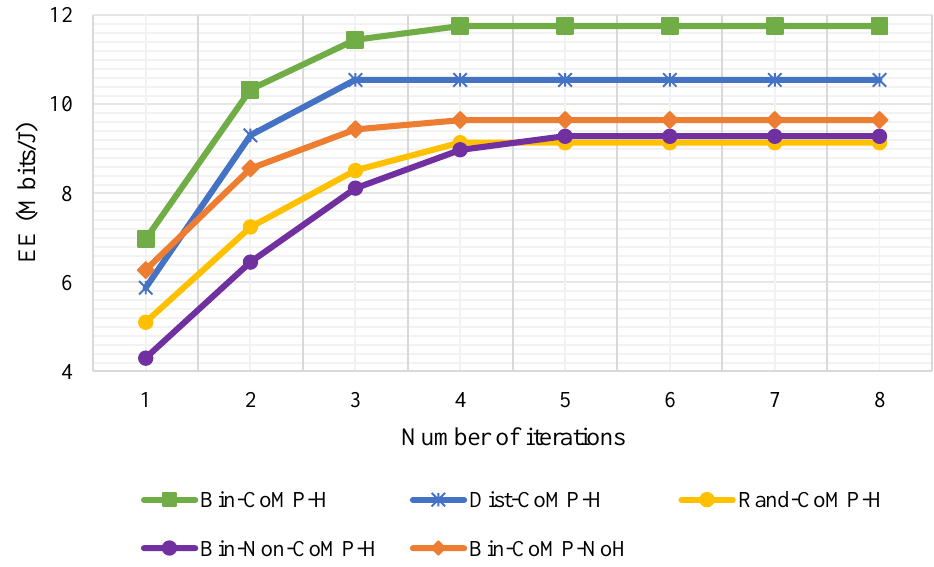
= 10 dB and four SBSs with M